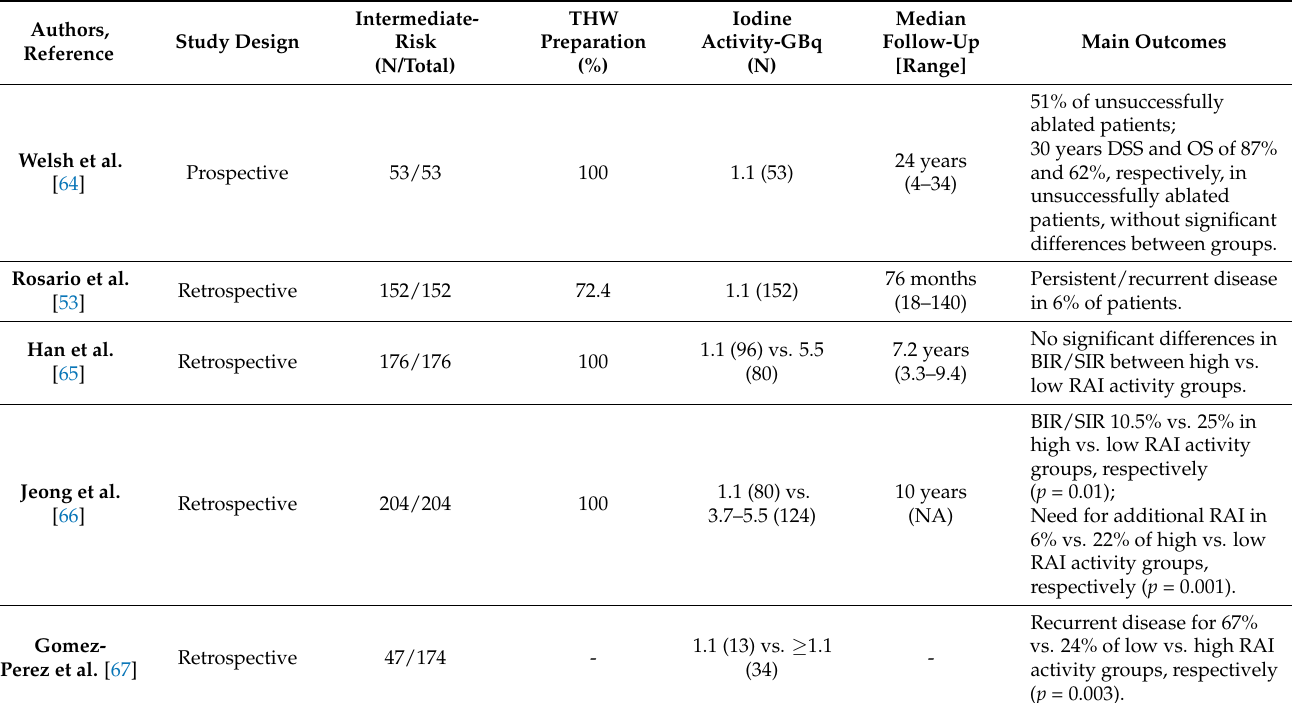
Table 2. Overview of studies considering lower RAI activity in intermediate-risk patients with mainly lower risk